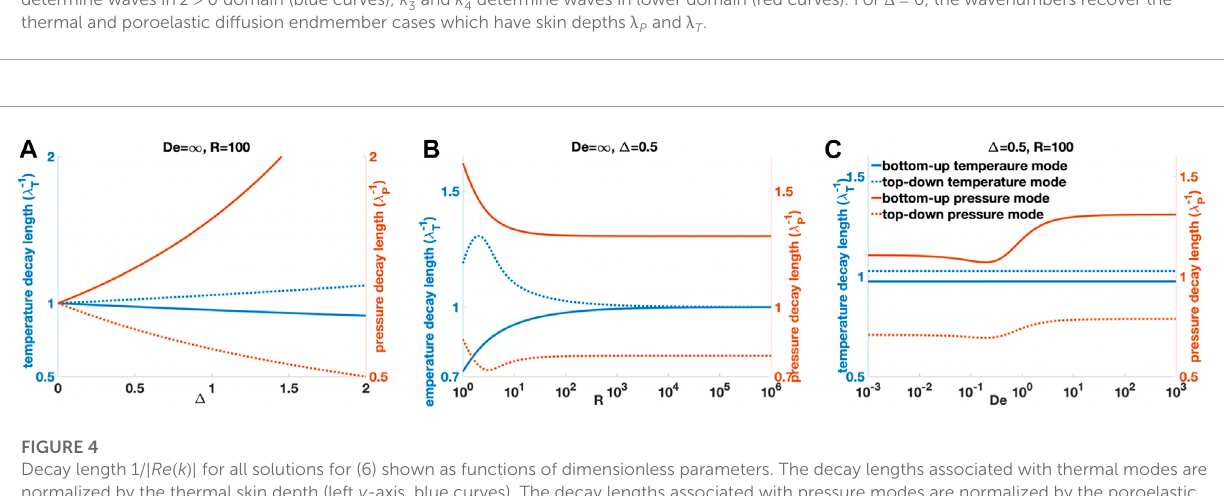
likely linked to the distance over which thermal advection is most efficient. The pressure propagation leads to discontinuous melt velocity at z = 0, indicating that the bottom-up transport and top- down transport results in different rate of melt inflow/removal at z = 0 ( Figure 5C ). The asymmetries in the transport of melt (i.e., melt velocity) and heat can be rationalized by the asymmetry of pressure propagation. With thermal mechanical coupling ( Δ ≠ 0 ) , the bottom-up pressure propagation has longer decay length, which corresponds to smaller pressure gradient and smaller